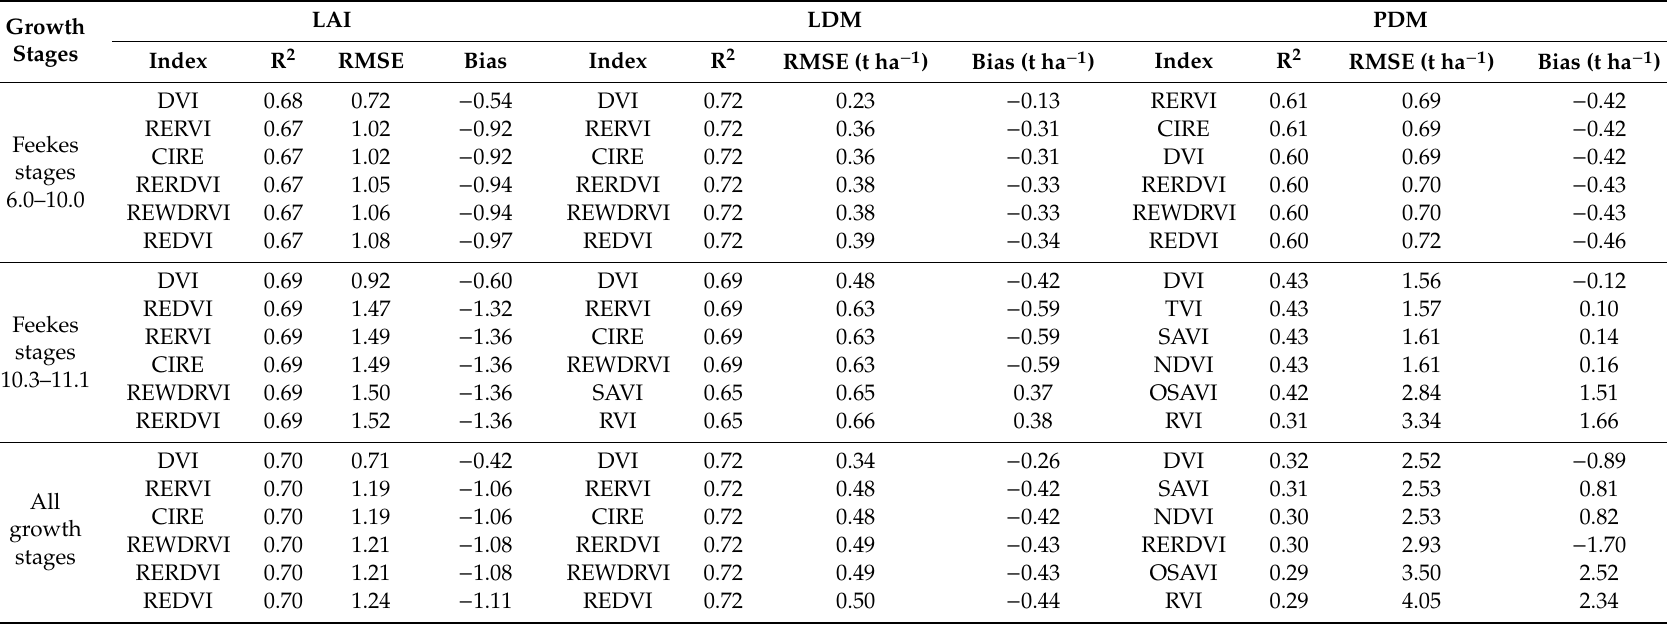
Table 6. Validation results for the pair-wise associations between top 6 vegetation indices and leaf area index (LAI), leaf dry matter (LDM) and plant dry matter (PDM) at di ff erent growth stages across varieties, sites (Xinghua) and years (2019). The full name of each vegetation index is shown in Table